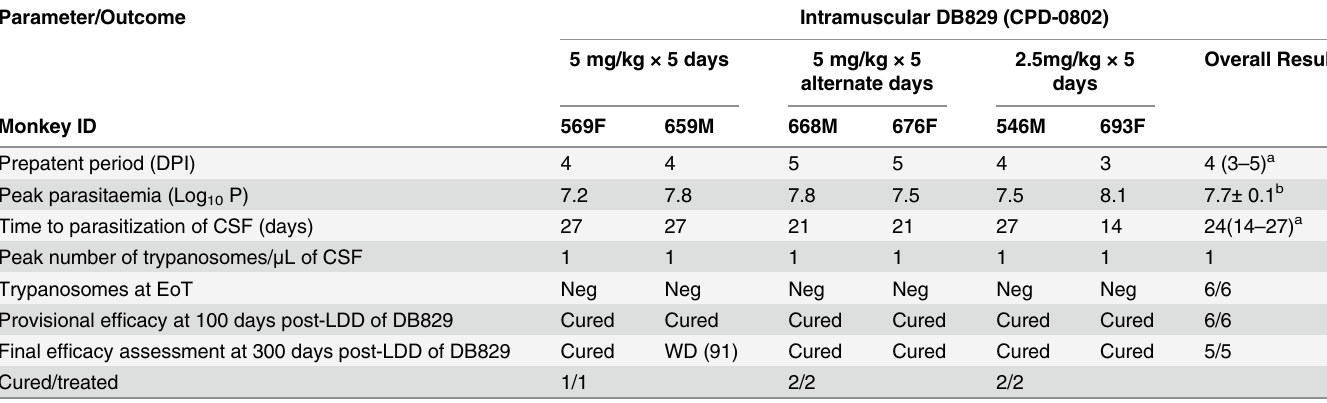
Table 1. Ef fi cacy of intramuscular DB829 against second stage T. b. rhodesiense infection in vervet